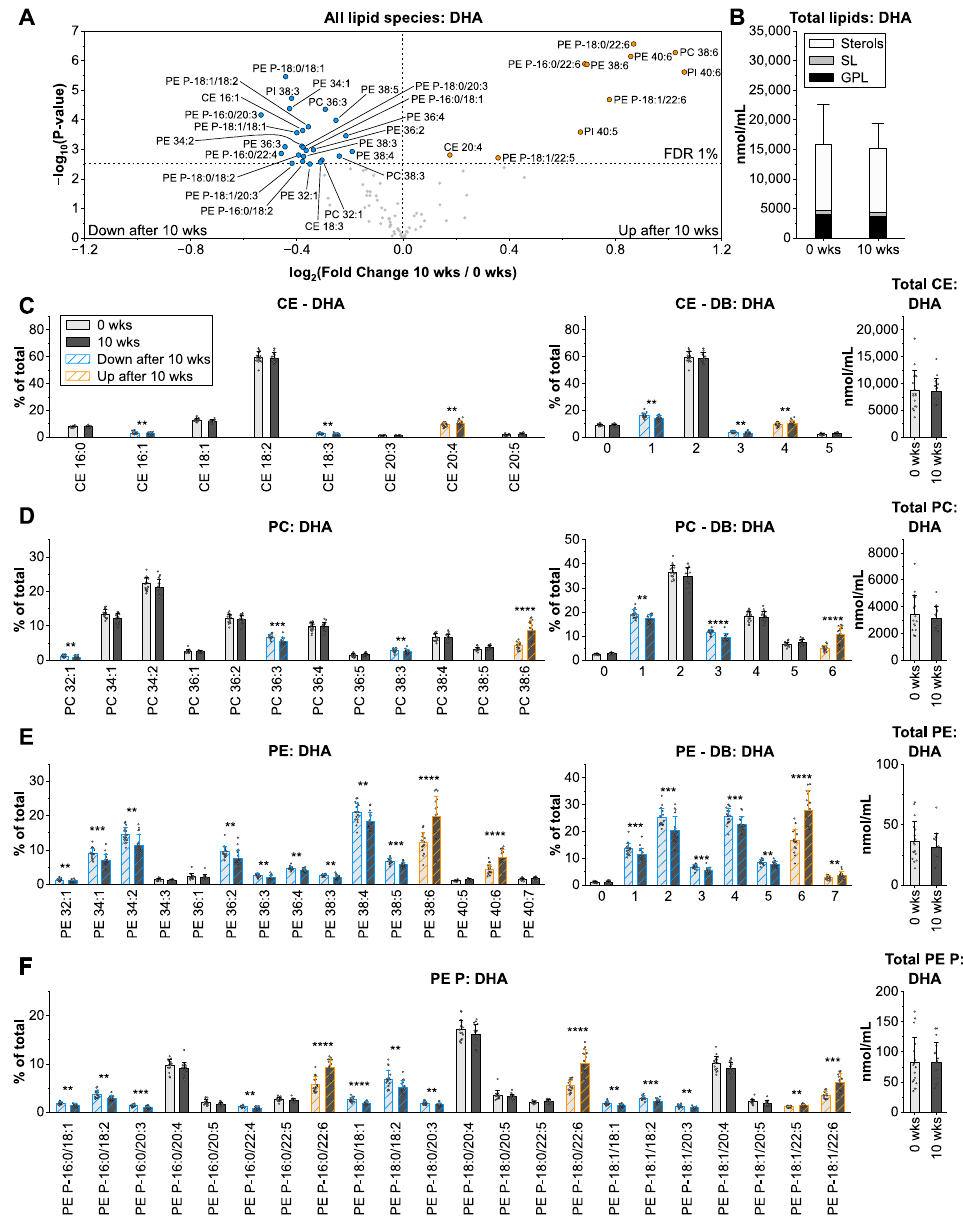
Figure 5. Impact of microalgae oil intervention on the human plasma lipidome. The arrangement of panels ( A – F ) is identical to Figure 2. Shown are means ± SD of lipid species with an average contribution > 1% from n = 17. ** p < 0.01, *** p < 0.001, **** p < 0.0001.